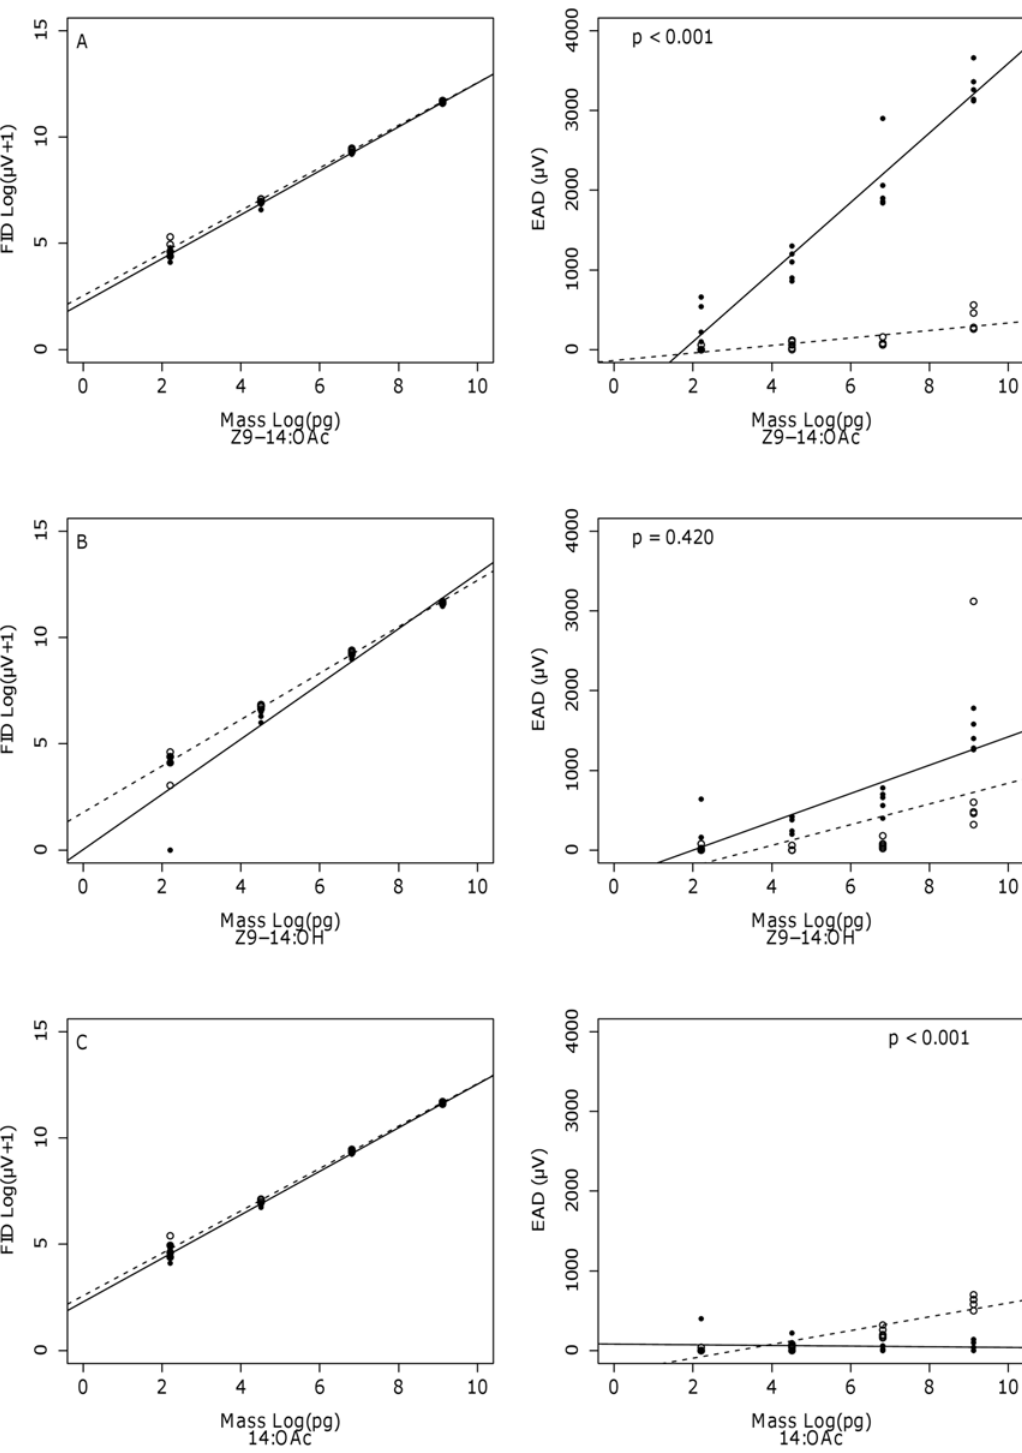
Fig 3. Fitted dose response curves of the FID compared to the EAG response of live Coryphodema tristis . Differences between the slope value for the fitted regression lines of males and females are indicated with p values (Ancova) for the EAD data. A = Z9-14:OAc, B = Z9-14:OH, C = 14:OAc. (Dashed lines = Female, Solid lines = Male, N = 5 at each level)